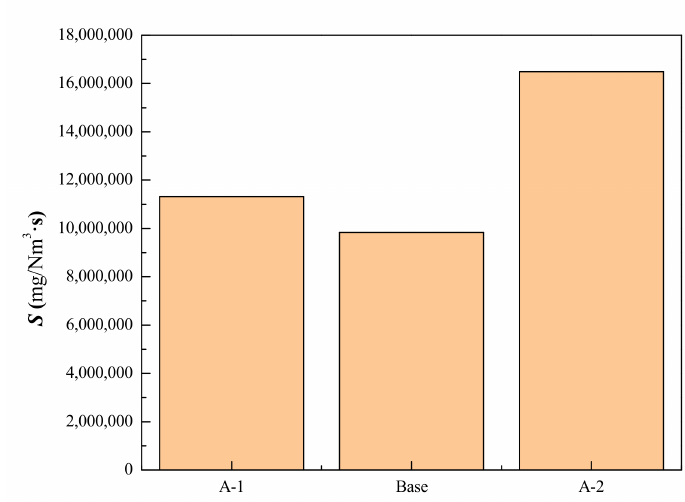
Figure 3. Influences of carbon addition in the sintering mixture on CO emissions. (The carbon amount: A-1 = 2.6%; Base = 2.8%; A-2 = 3.0%).